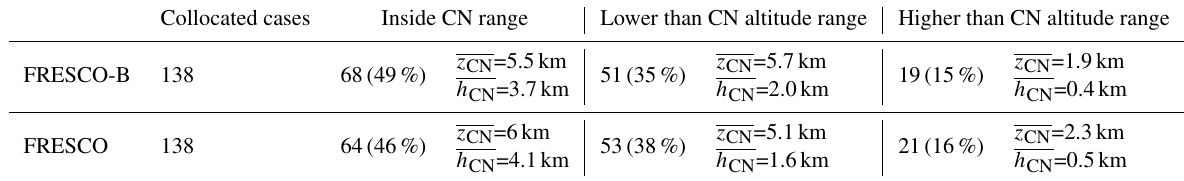
Table 7. Number of collocated cloud cases for which FRESCO-B and FRESCO cloud pressures are inside, lower or higher than the Cloud- net (CN) cloud range. For each case, the mean Cloudnet cloud altitude ( z CN ) and geometrical thickness ( h CN ) are indicated. Collocated Cloudnet–GOME-2B data for July and August 2014 from the Cloudnet sites of Hyytiälä, Jülich, Leipzig, Lindenberg, Palaiseau and Potenza. Collocated cases Inside CN range Lower than CN altitude range Higher than CN altitude range z CN =5.5km z CN =5.7km z CN =1.9km FRESCO-B 138 68(49%) 51(35%) 19(15%) h CN =3.7km h CN =2.0km h CN =0.4km z CN =6km z CN =5.1km z CN =2.3km FRESCO 138 64(46%) 53(38%) 21(16%) h CN =4.1km h CN =1.6km h CN